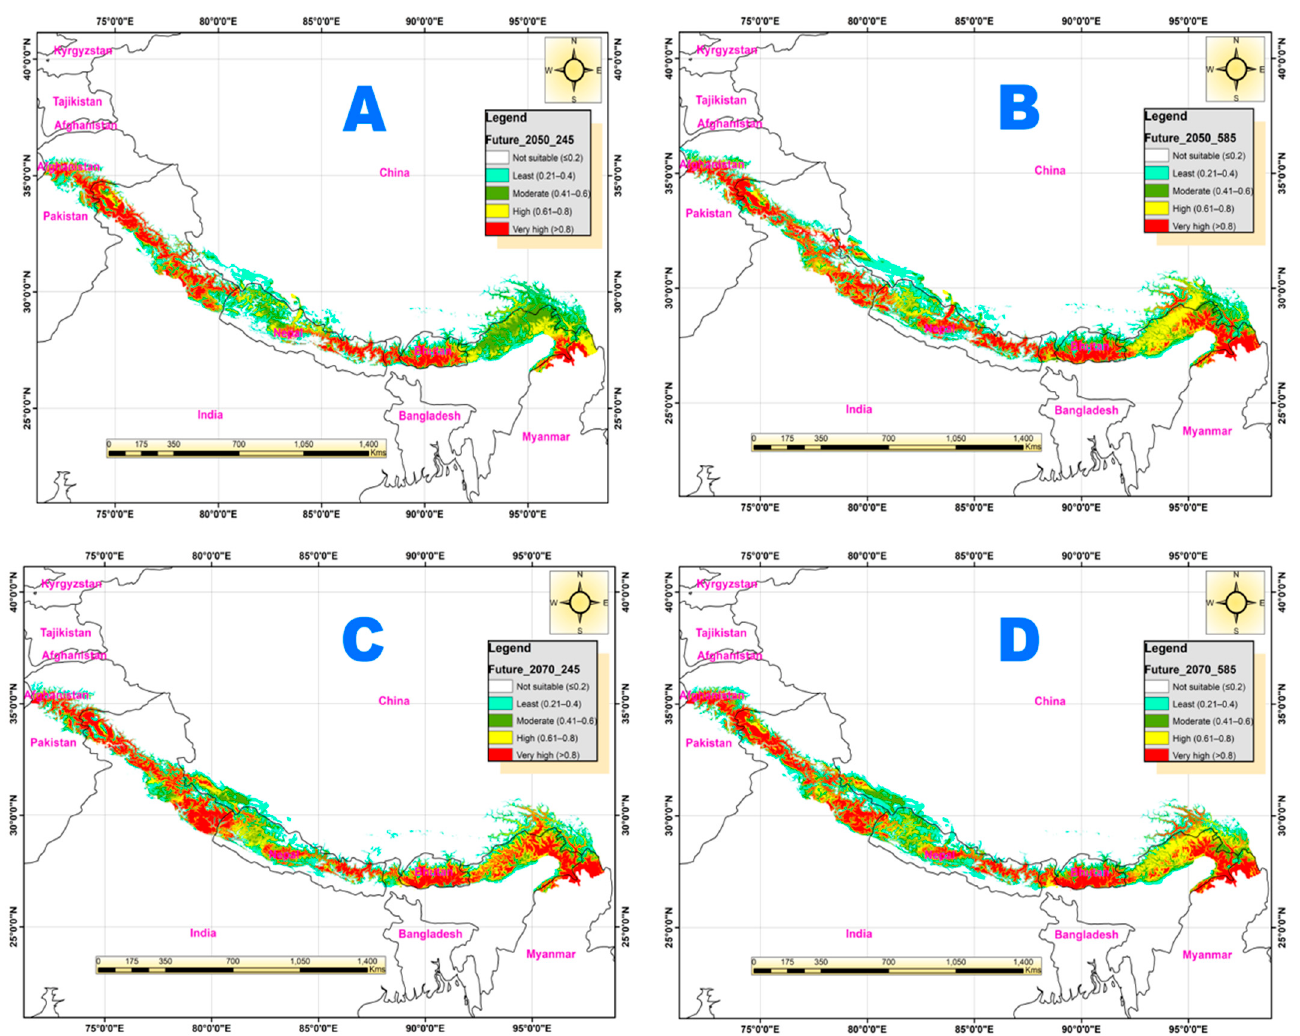
Figure 7. MaxEnt prediction maps displaying the habitat suitability classes under future climate change scenario ( A = SSPs-245 of 2050s; B = SSPs-585 of 2050s; C = SSPs-245 of 2070s; D = SSPs-585 of 2070s).